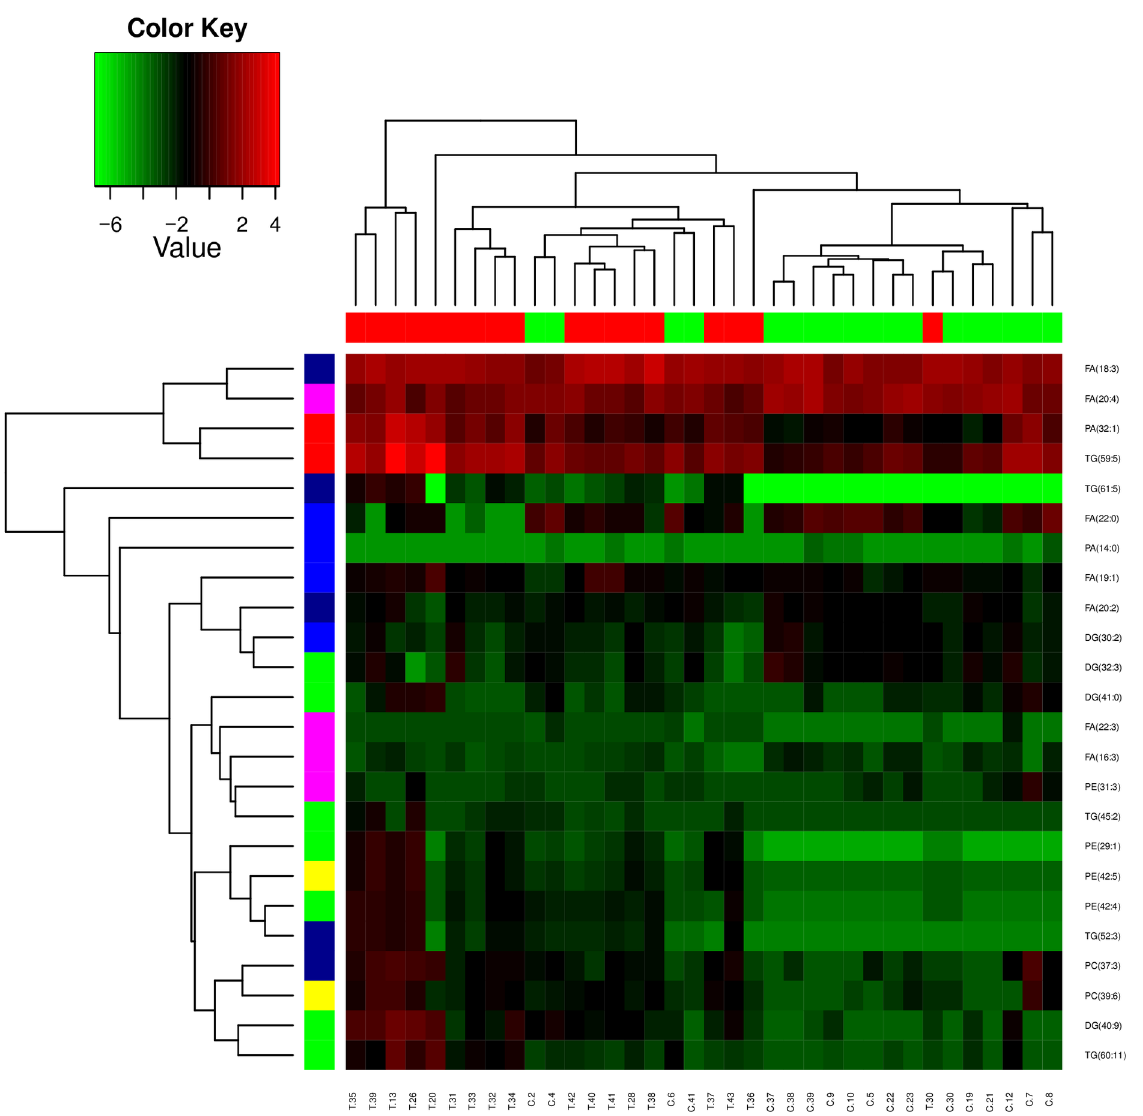
Fig 3. Unsupervised hierarchical clustering was performed using the log transformed values of lipid abundance determined from mass spectrometry data. On the heat map patients were shown horizontally whereas lipids vertically. In the upper color bar the cancer patients are marked in red, the controls are shown in green. In the side color bar each colour represents a specific class of lipids. The dendrograms represent the distance between the